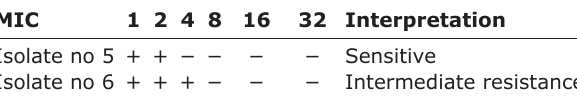
Table-8: Determining MIC of Escherichia coli isolates.